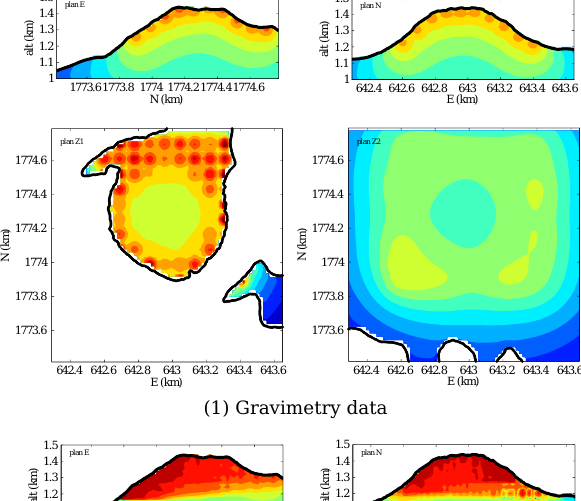
Fig. 6.3 and 6.4 for the La Soufrière